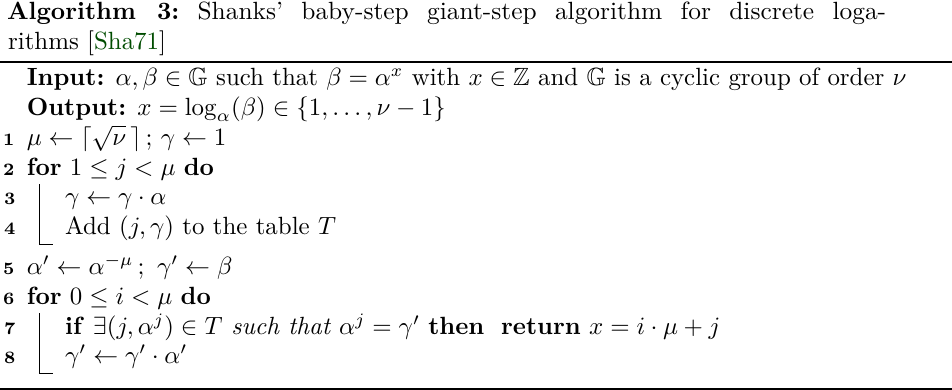
Algorithm 3: Shanks’ baby-step giant-step algorithm for discrete loga- rithms